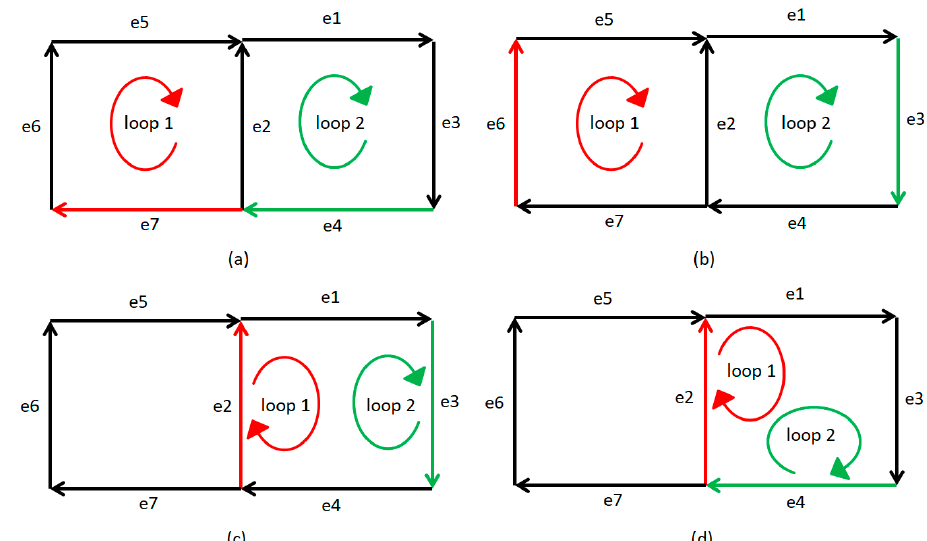
Figure 3. Division of the minimum closed loops based on different spanning trees (black edges) and the corresponding co-tree branches (red and green edges). ( a ) Loop one is e7-e6-e5-e2 and loop two is e4-e2-e1-e3; ( b ) loop one is e6-e5-e2-e7 and loop two is e3-e4-e2-e1; ( c ) loop one is e2-e1-e3-e4 and loop two is e3-e4-e2-e1; ( d ) loop one is e2-e1-e3-e4 and loop two is e4-e2-e1-e3.